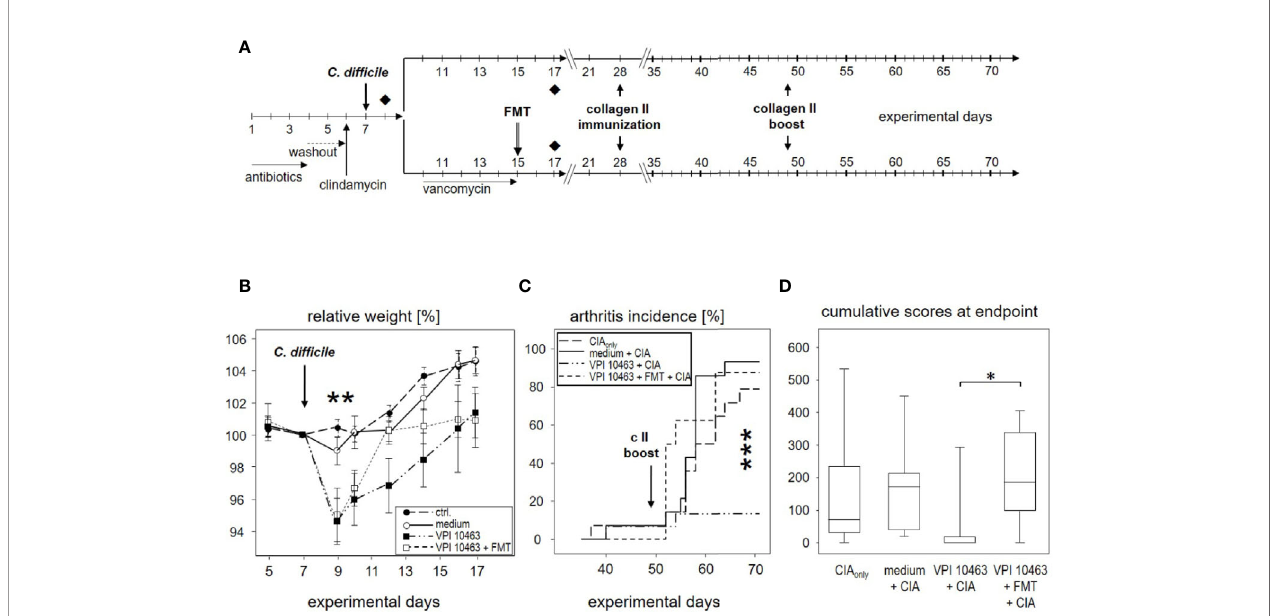
FIGURE 5 | Eradication of VPI 10463 and subsequent fecal microbiota transplantation obliterated any attenuating effect. (A) experimental scheme with Clostridioides dif fi cile infection, subsequent eradication, and fecal microbiota transplantation (FMT). (B) Mean (± SEM) relative weight curves of untreated controls (n = 8), mice gavaged with bacterial growth medium (n = 8), infected (VPI 10463: n = 8) and infected, eradicated, and fecal microbiota transplanted mice (VPI 10463 + FMT: n = 8). Asterisks denote signi fi cant weight differences between the experimental groups (p = 0.0057). (C) inverted Kaplan-Meier plot shows incidences of collagen- induced arthritis (CIA) with an extremely signi fi cant difference between the groups as calculated via log rank (Mantel-Cox) test (p-value = 0.000269). (D) Box-plots present cumulative arthritis scores at endpoint. A Kruskal-Wallis test resulted in a p-value of